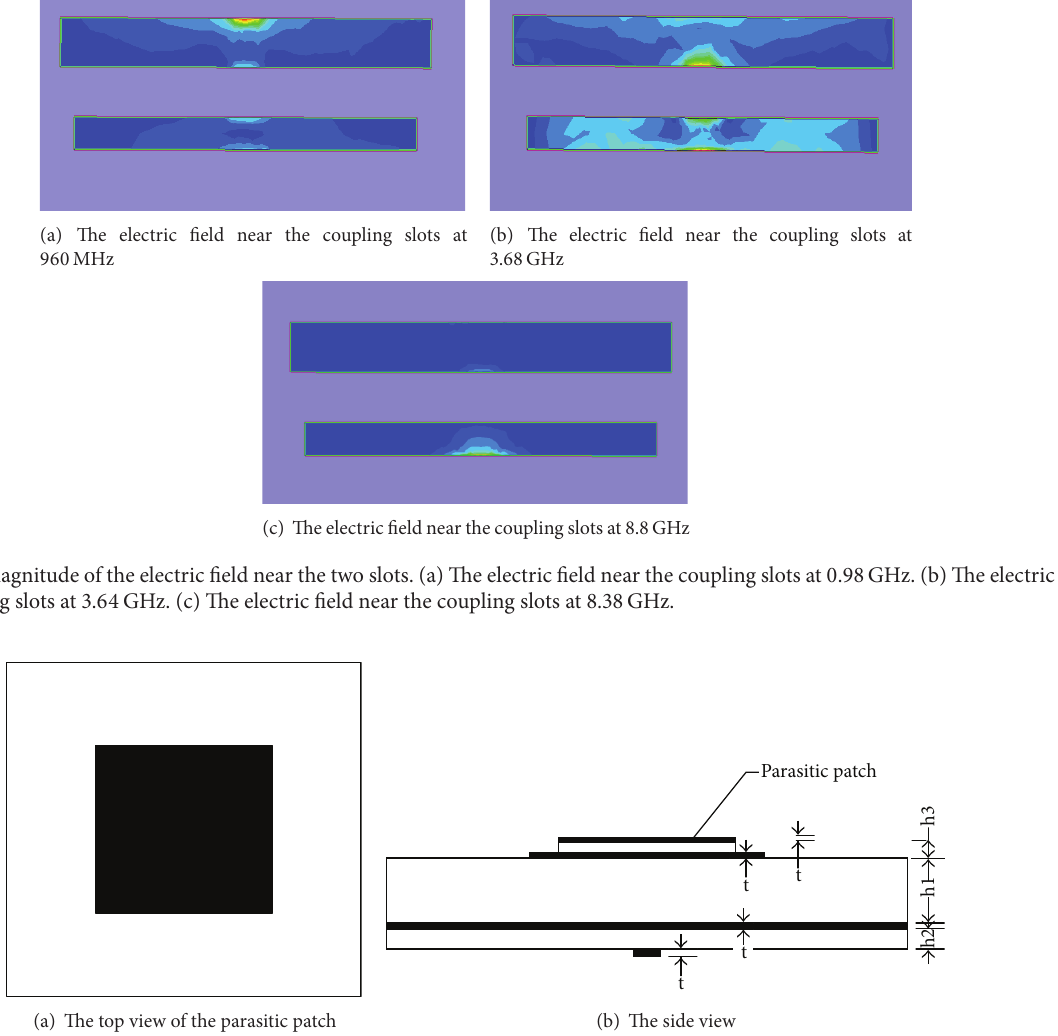
Figure 6: Geometry of the two-layer Sierpinski patch antenna. (a) Top view of the parasitic patch. (b) The side